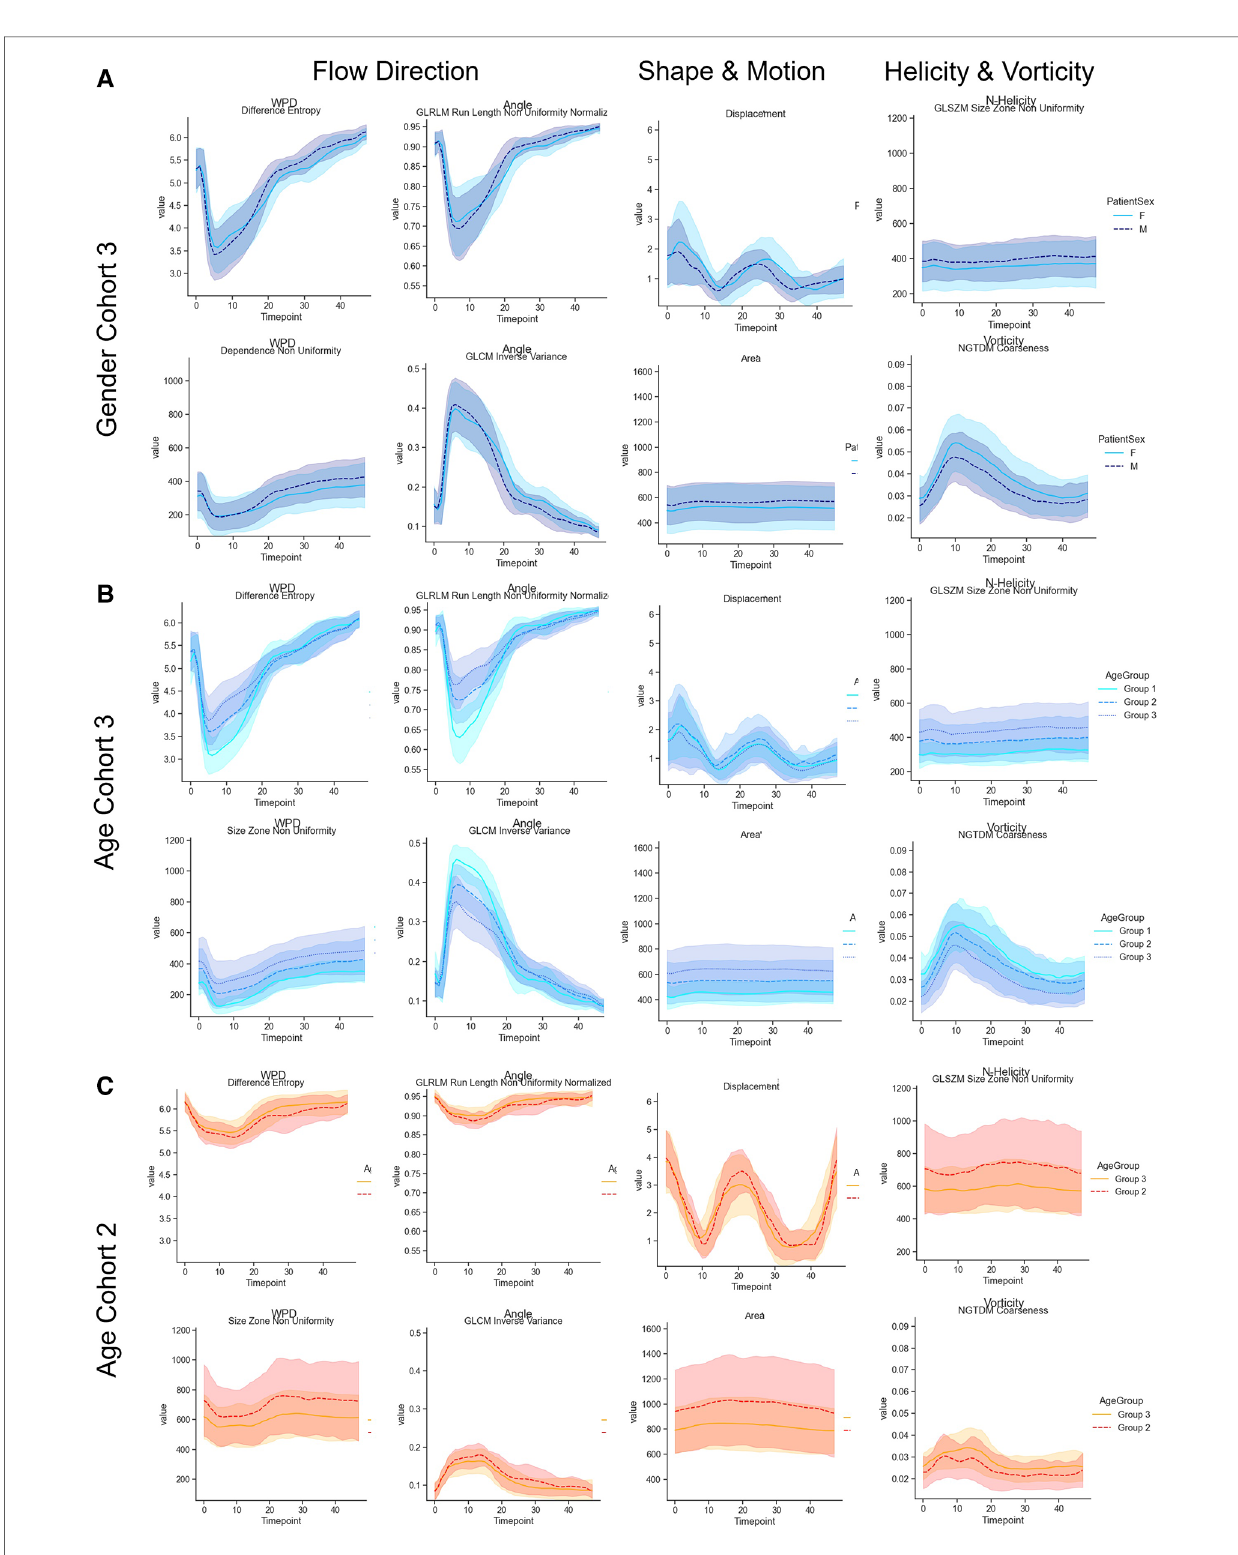
FIGURE 3 ( A ) Comparison of radiomics feature value ranges in male and female in cohort 3. ( B ) Comparison of radiomics feature value ranges for different age groups for cohort 3 (no valve disease). The curves represent age groups 1 – 3. ( C ) Shows the curves of age groups 2 and 3 for cohort 2 (aortic valve stenosis). The selected features describe patterns related to the fl ow direction, shape and motion, and normalized helicity and vorticity-related patterns over the complete cardiac